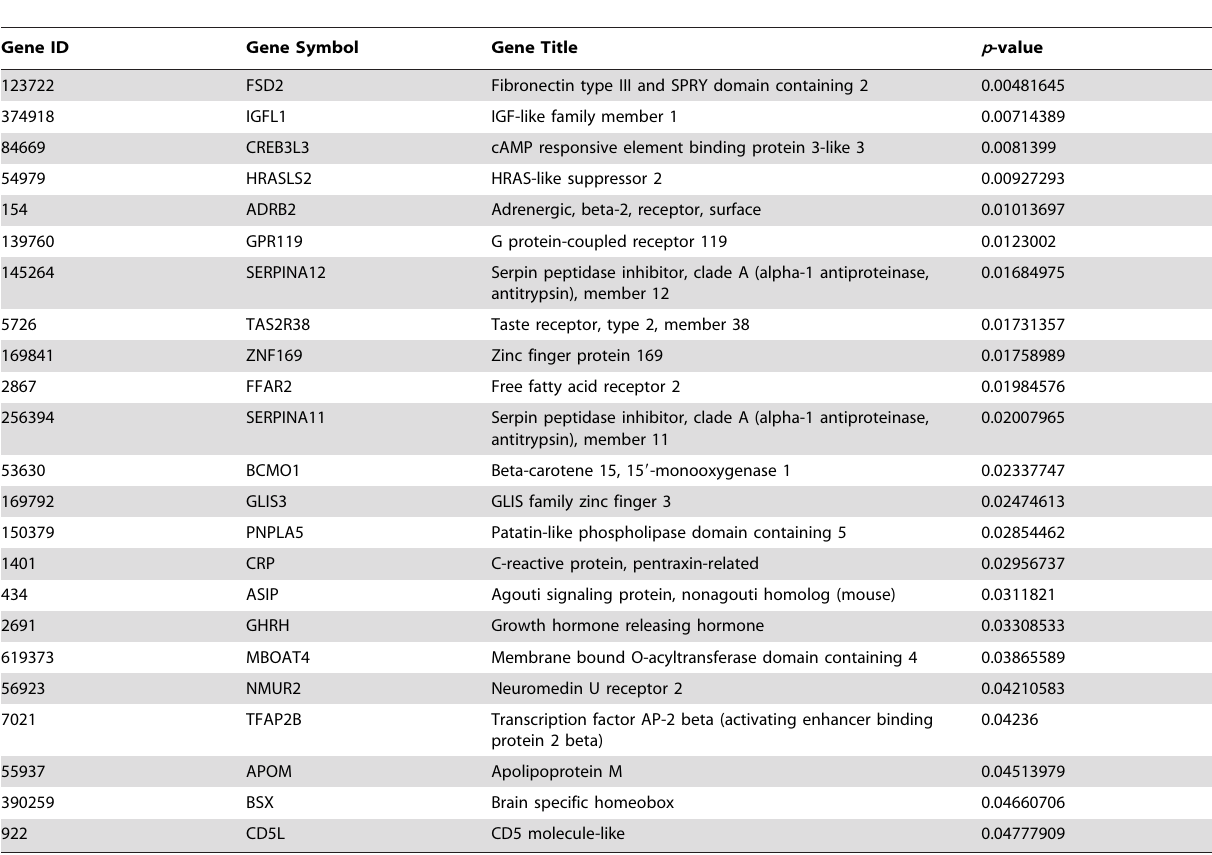
Table 3. Expression p-values for genes whose expression levels were negatively correlated with weight gain.